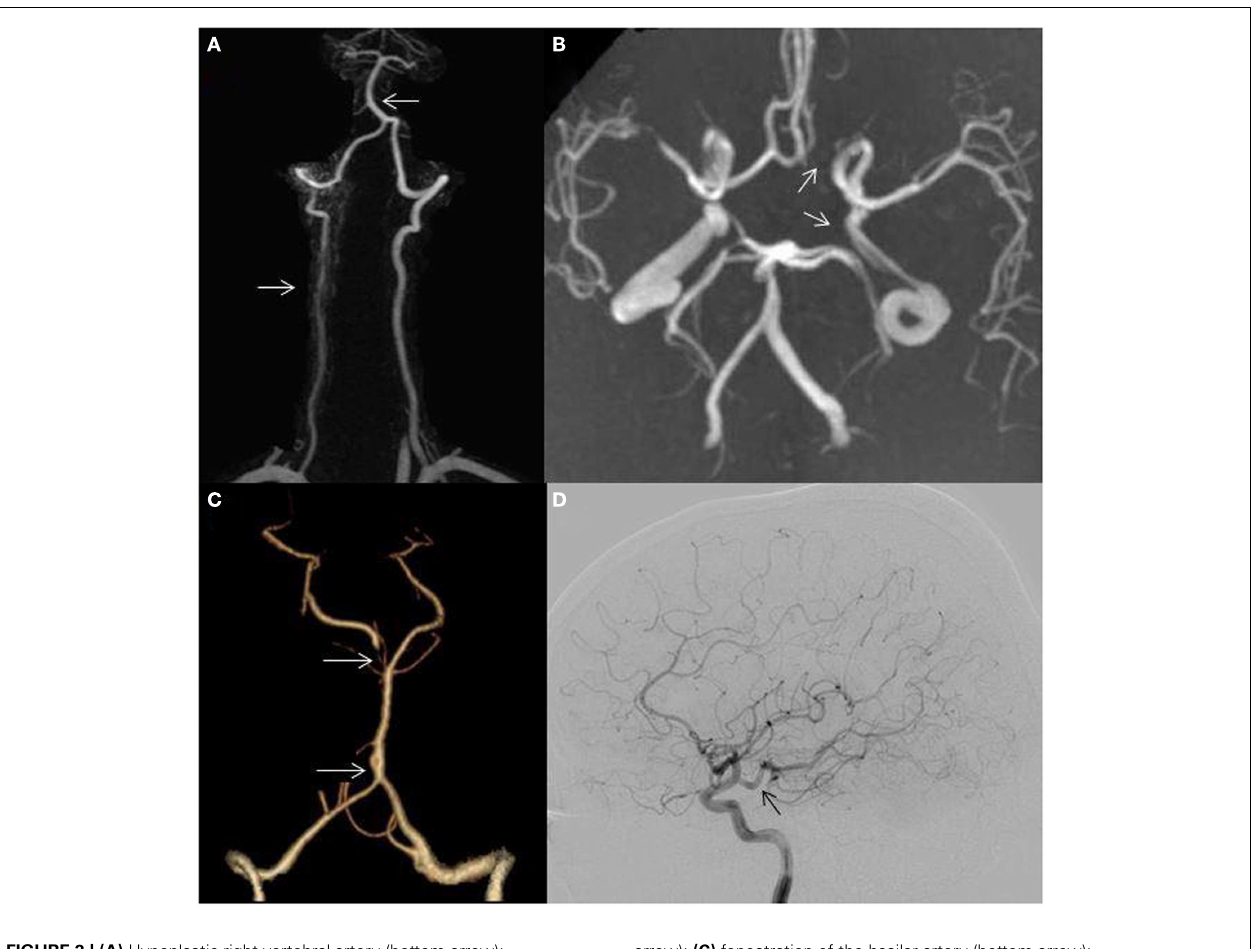
FIGURE 2 | (A) Hypoplastic right vertebral artery (bottom arrow); basilar artery displacement opposite to the dominant vertebral artery (top arrow); (B) incomplete circle ofWillis, absent left posterior communicating artery (bottom arrow), absent left A1 segment (top